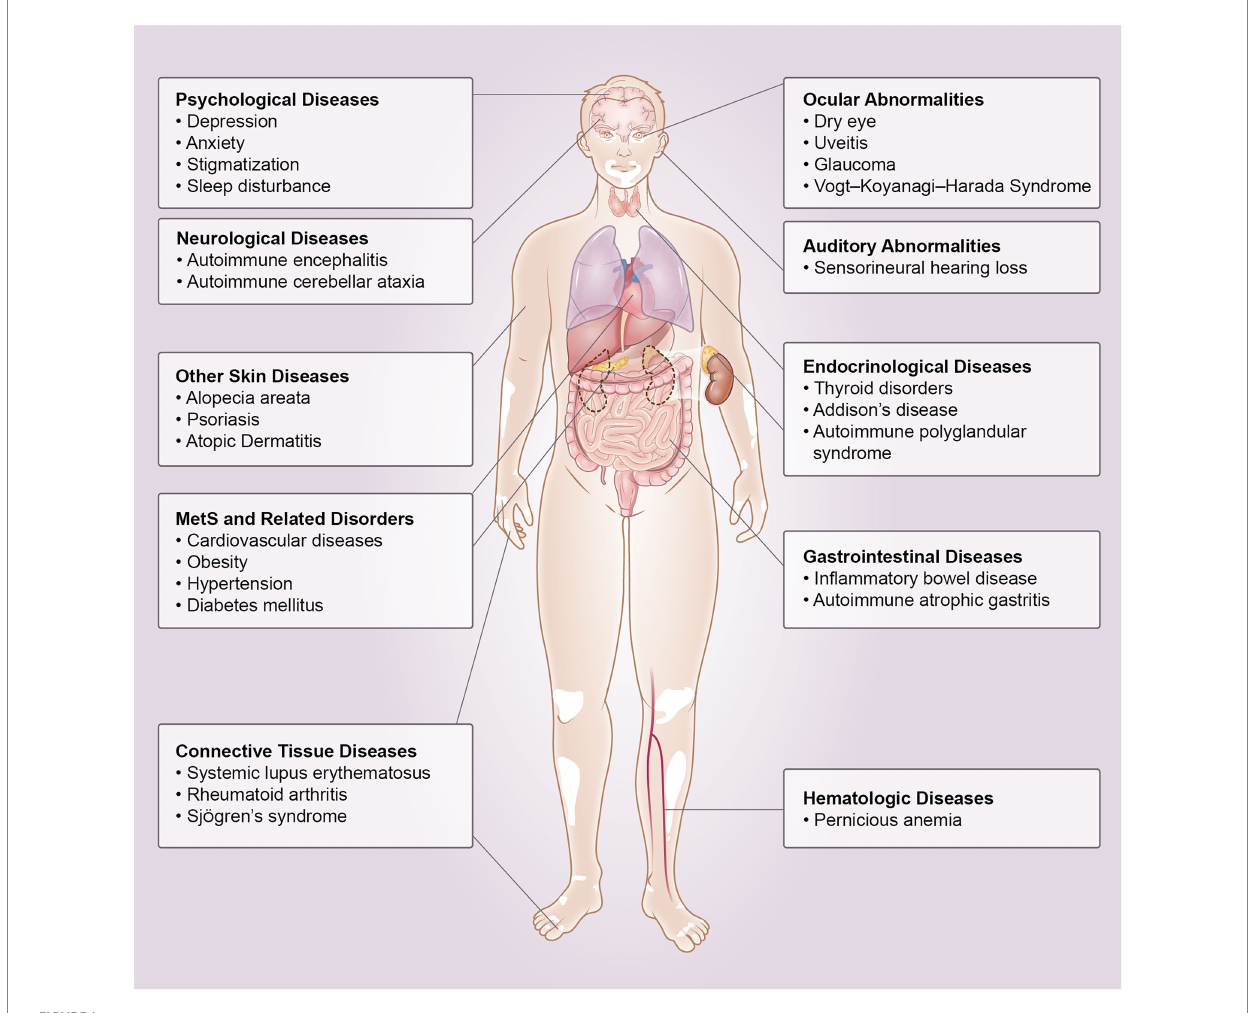
FIGURE 1 Comorbidities associated with vitiligo. MetS: metabolic